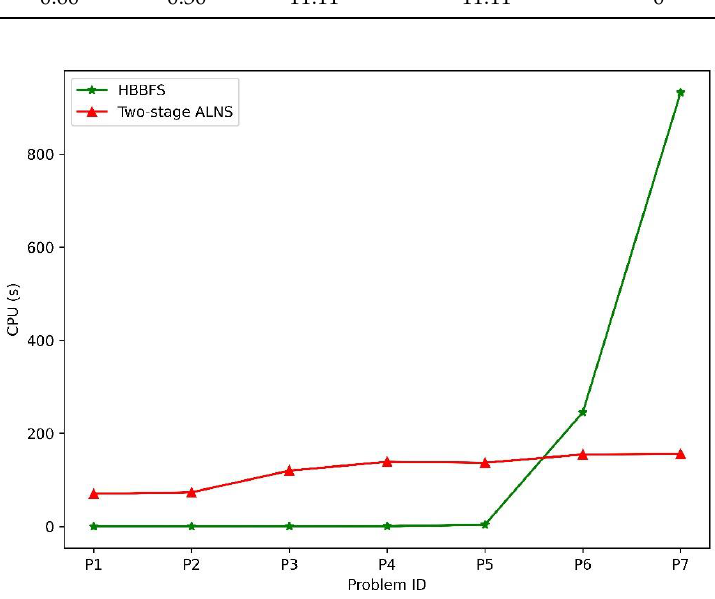
Figure 3. Comparison of the CPU time between the two-stage ALNS and HBBFS methods during the team formation stage.